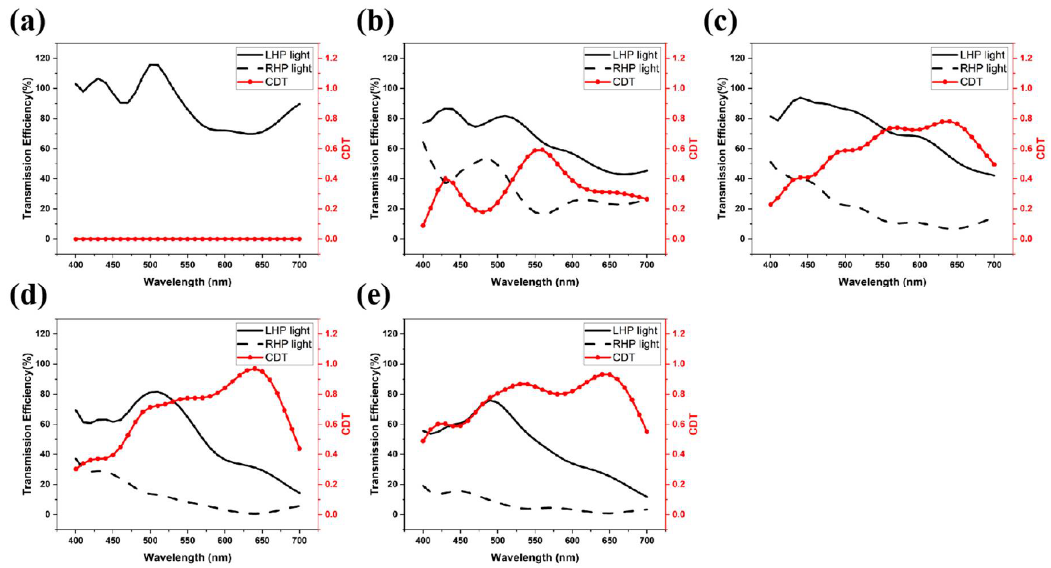
Figure 4. The transmission efficiency of LHP, RHP light and CDT of our proposed nanostructures, the combinations of nanogratings and nanocuboids for: ( a ) 1-layer, ( b ) 2-layer, ( c ) 3-layer, ( d ) 4-layer, ( e ) 5-layer.